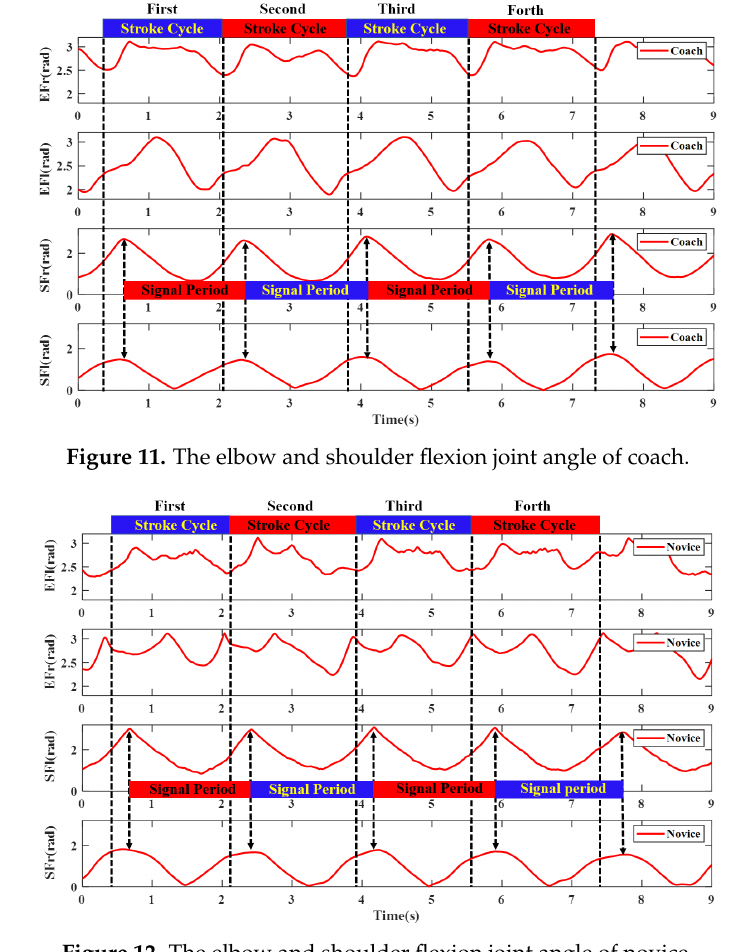
Figure 12. The elbow and shoulder flexion joint angle of novice.